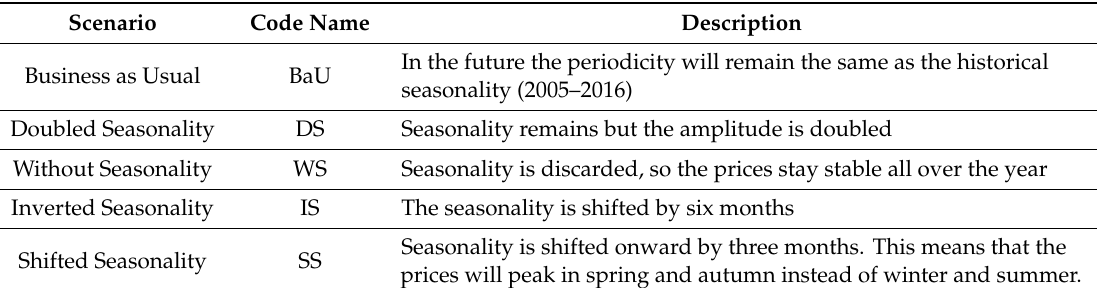
Table 5. Price scenarios used in this